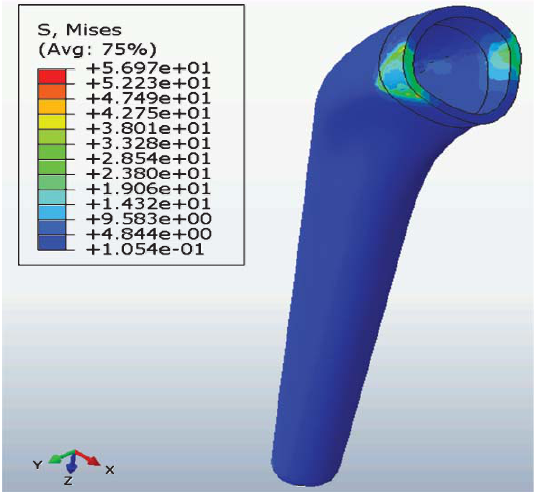
Fig. 10. Equivalent stress (MPa) distribution in the cement